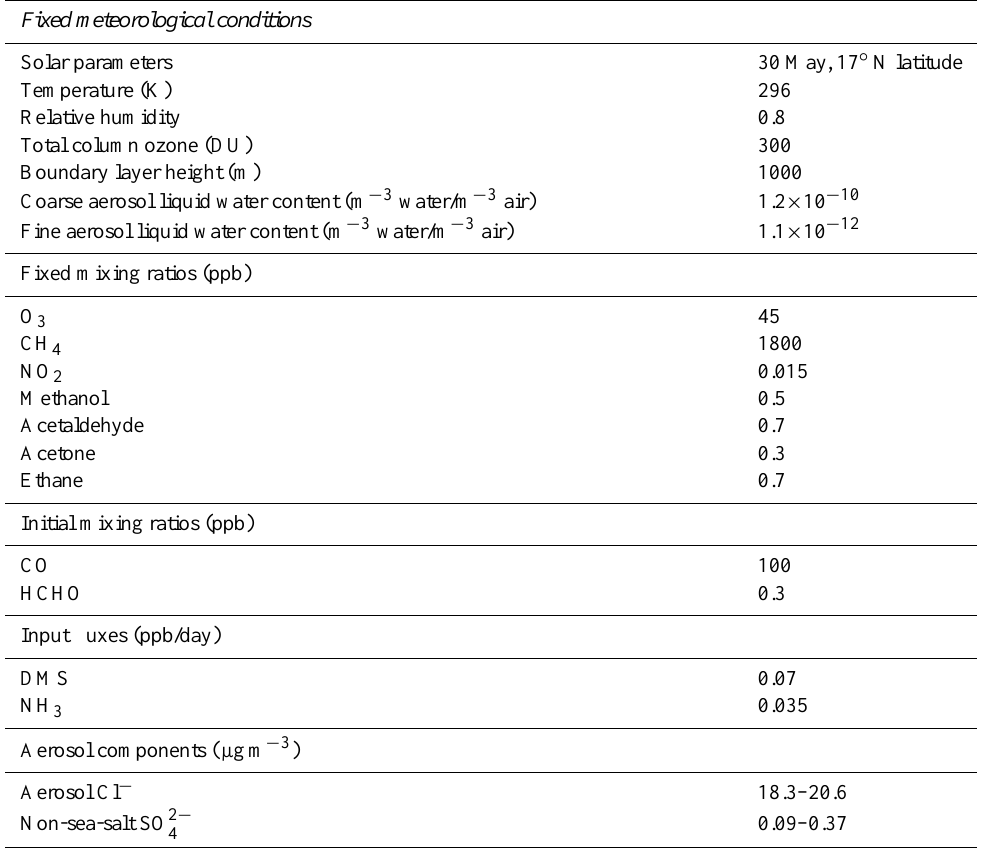
Table 2. Boundary conditions which were used for all model runs. O 3 , CO, and aerosols were based on concurrent measurements. Hydro- carbons and NO 2 were based on measurements in the same season in 2007. Aerosol Cl − and SO 2 − the simulations are given.